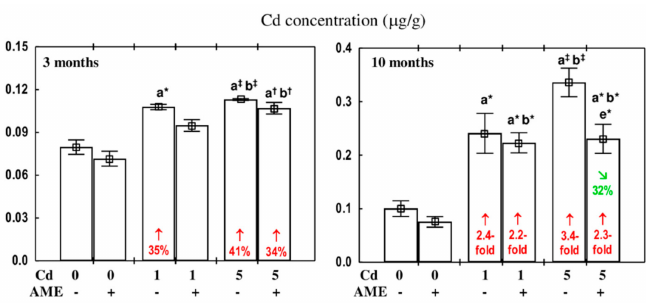
Figure 3. The e ff ect of the extract from Aronia melanocarpa L. berries (AME) on cadmium (Cd) concentration in the submandibular gland of female rats exposed to this xenobiotic. The animals received cadmium in the diet at the concentration of 0, 1, and 5 mg Cd / kg and / or 0.1% aqueous AME ( + ) or not ( − ). Data are presented as mean ± SE for eight rats. Statistically significant di ff erences (Kruskal–Wallis post hoc test): a compared to the control group, b compared to the AME group, e compared to the Cd 5 group, where * p < 0.05, † p < 0.01, and ‡ p < 0.001. Numerical values in bars